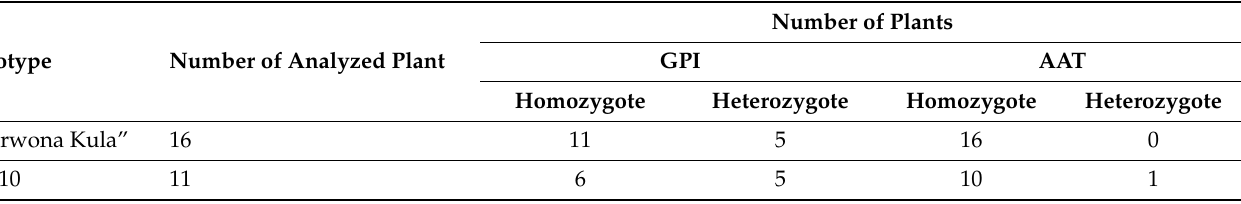
Table 10. Homozygosity evaluation using analysis with isoenzymes GPI and ATT of gynogenetic doubled haploids of red beet “Czerwona Kula” and 3/2010 breeding